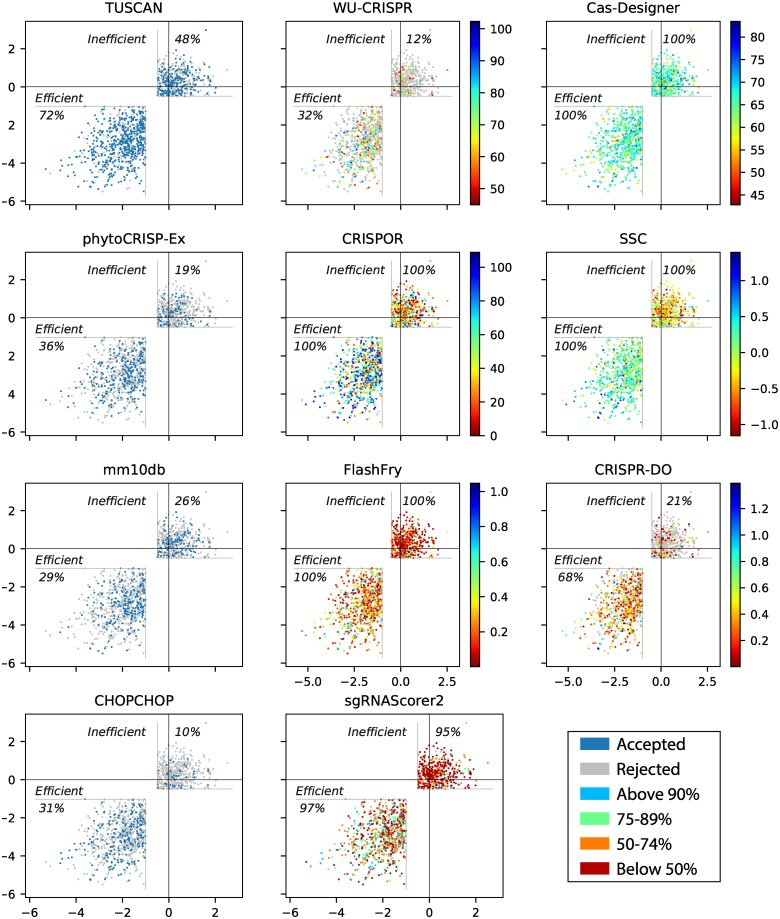
Tool performance on Xu guides.For TUSCAN, mm10db, CHOPCHOP and phytoCRISP-Ex, colours indicate the whether a guide was accepted by the tool. For sgRNAScorer2, each colour indicates which percentile a particular guide scored in. For all others, colours represent the score distribution over the dataset.